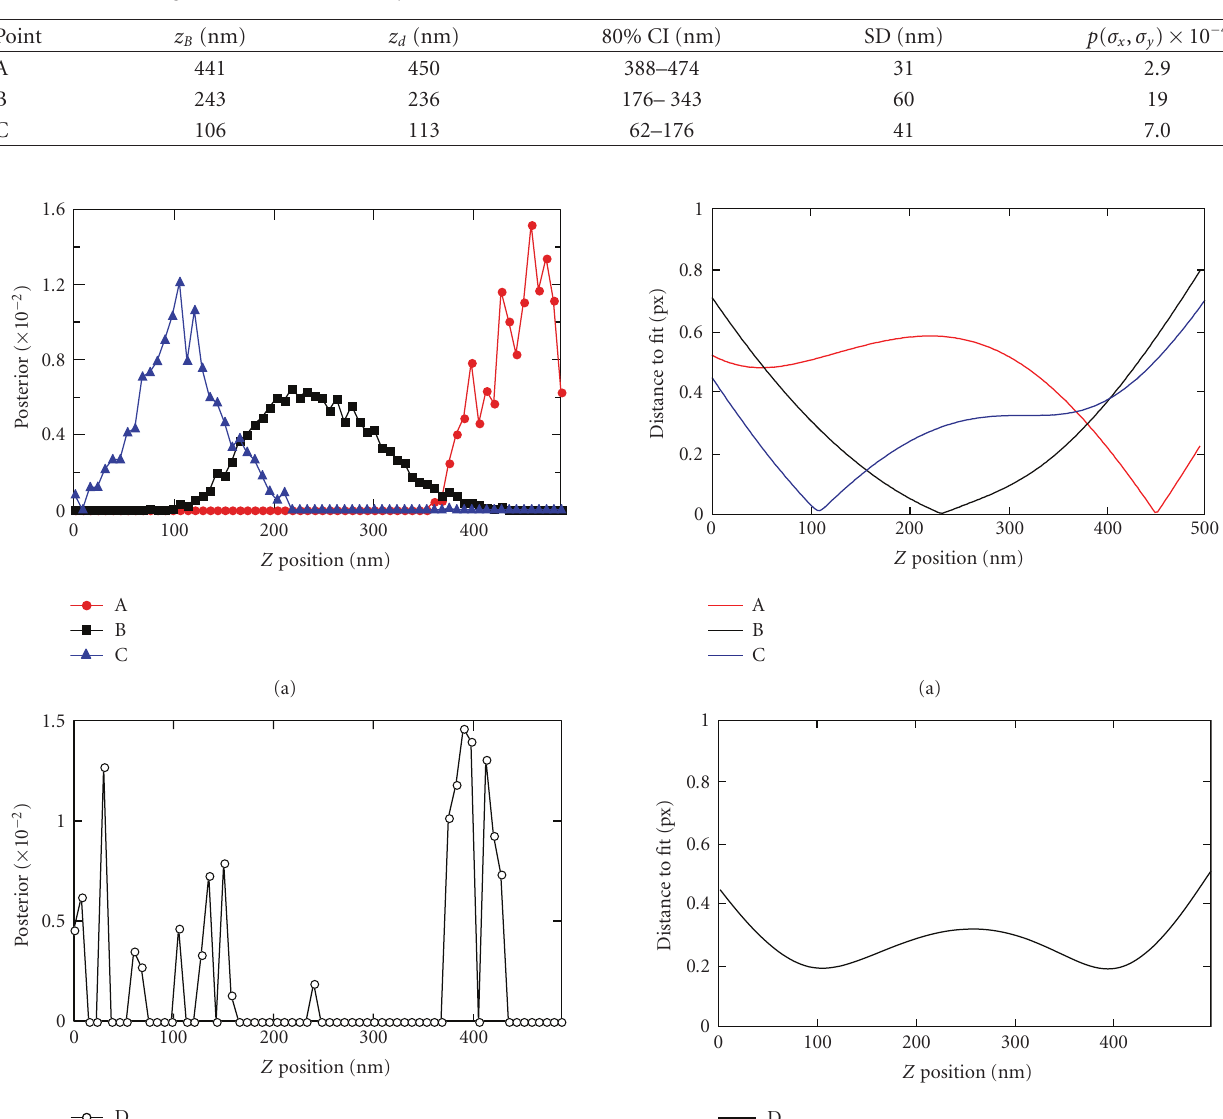
Table 1: Localization results for points A–D from Figure 1(c). z B : position estimate using the Bayesian algorithm, z d : position estimate using the method of Huang et al. [12], CI: credibility interval, SD: standard deviation.